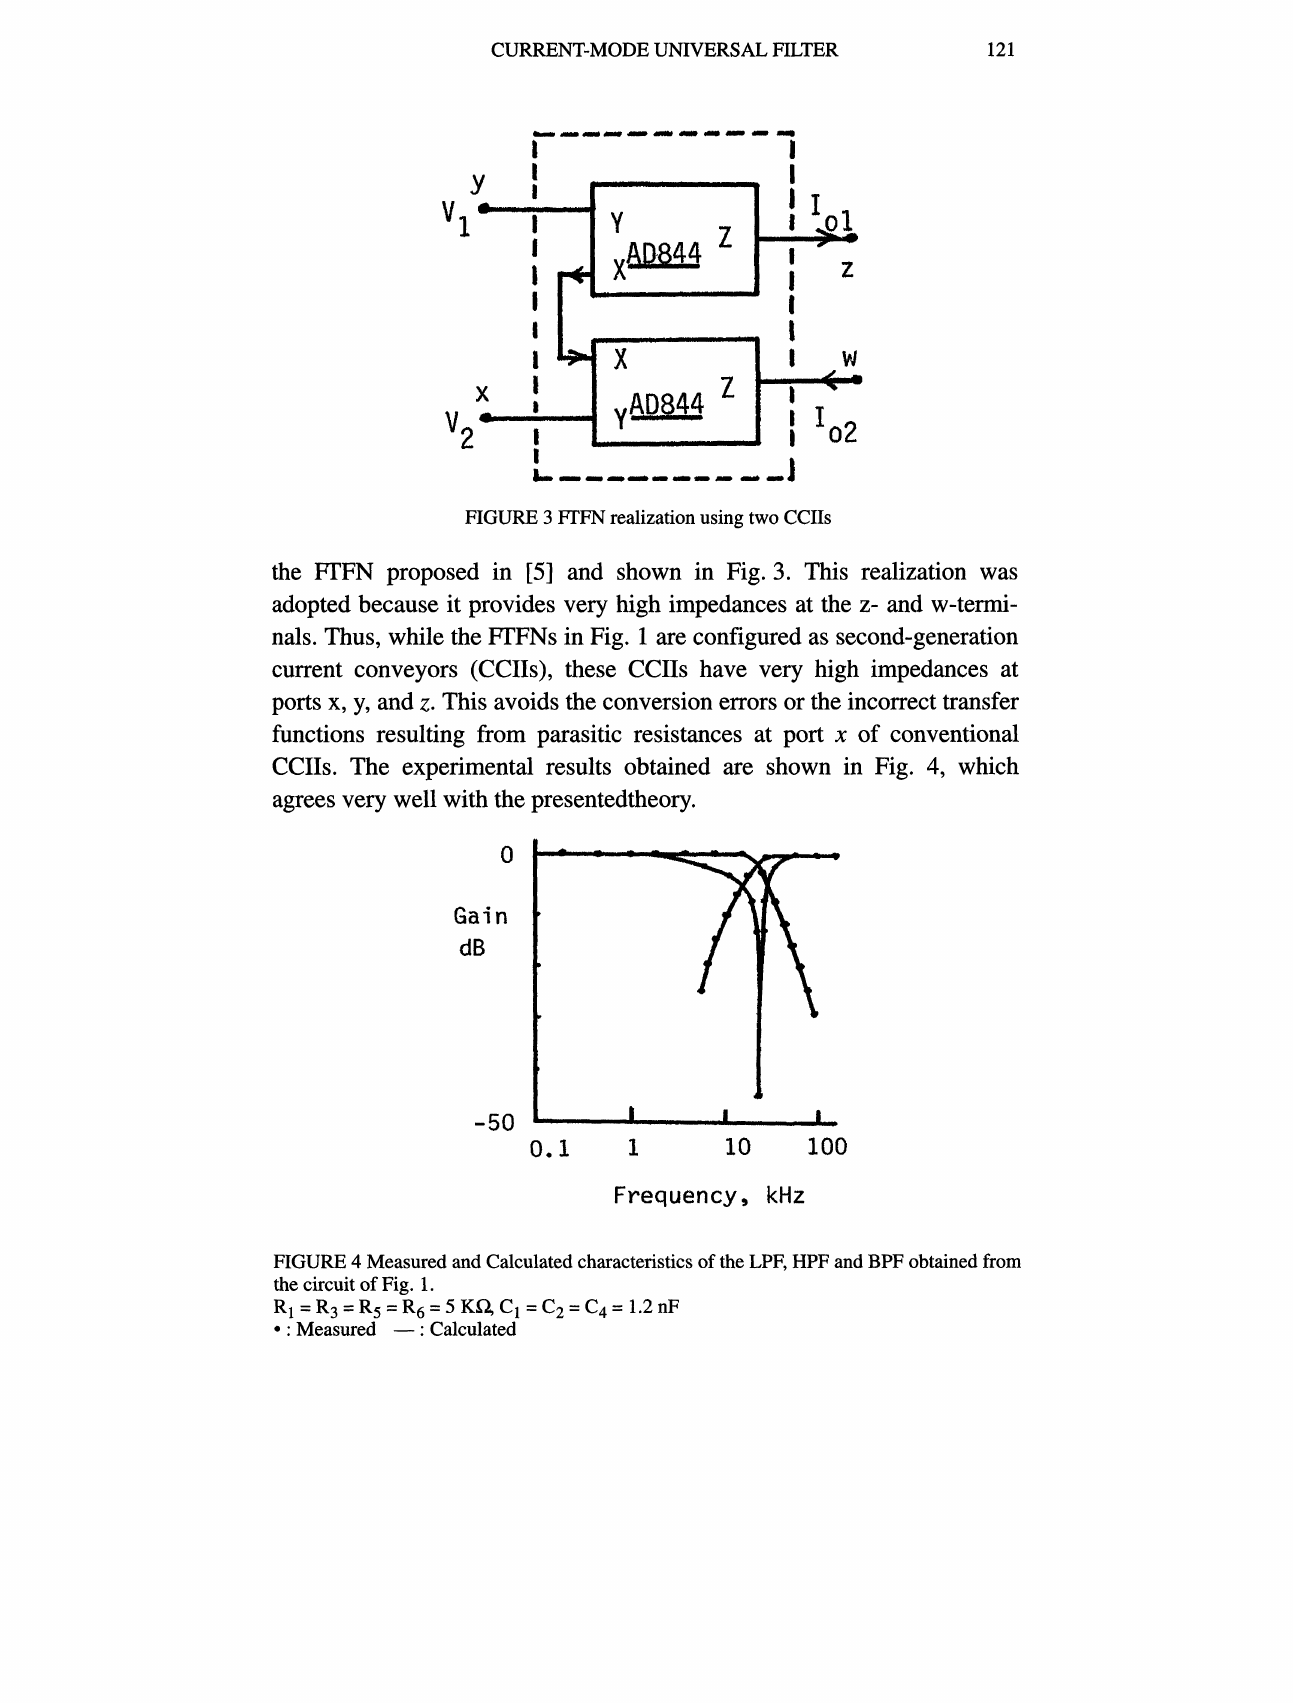
FIGURE 4 Measured and Calculated characteristics of the LPF, HPF and BPF obtained from the circuit of Fig.